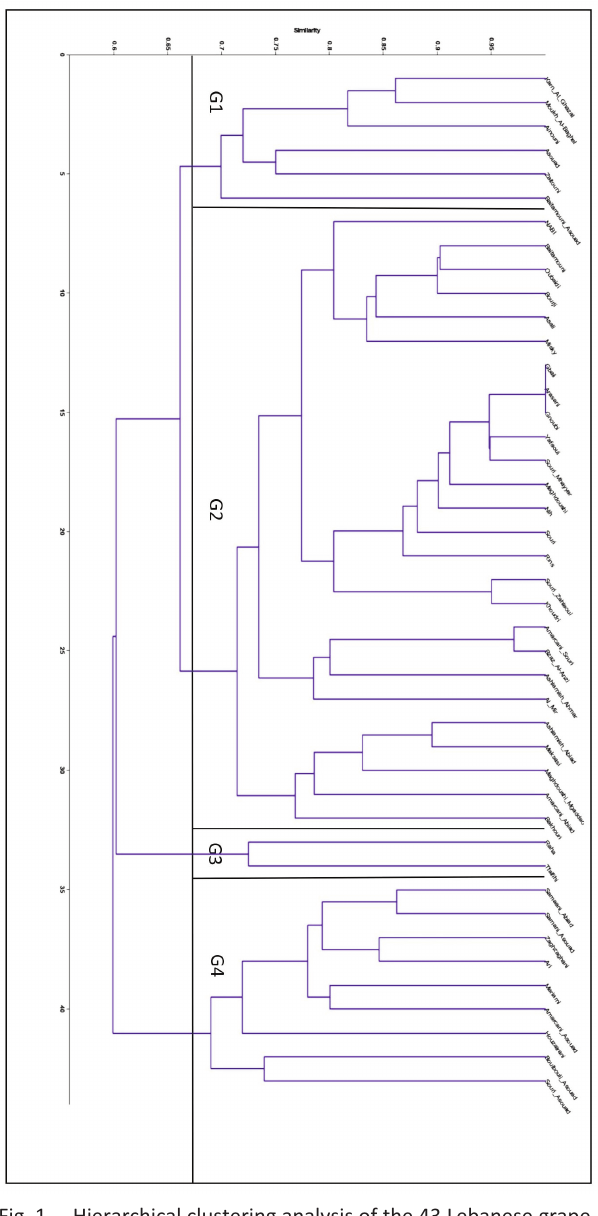
Fig. 1 ­ Hierarchical clustering analysis of the 43 Lebanese grape­ vine cultivars, based on 9 ISSR primers using Jaccard distance and